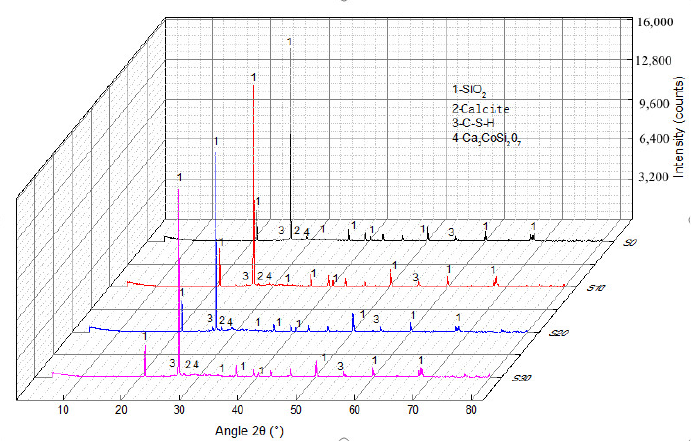
Figure 16. XRD patterns of AASSC with different contents of silico-manganese slag.